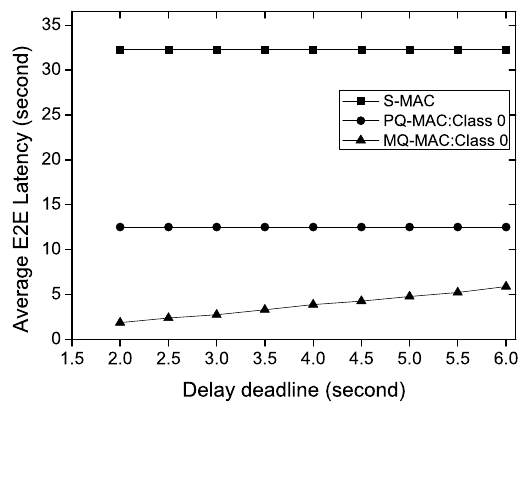
Figure 9. Average E2E latency varying delay